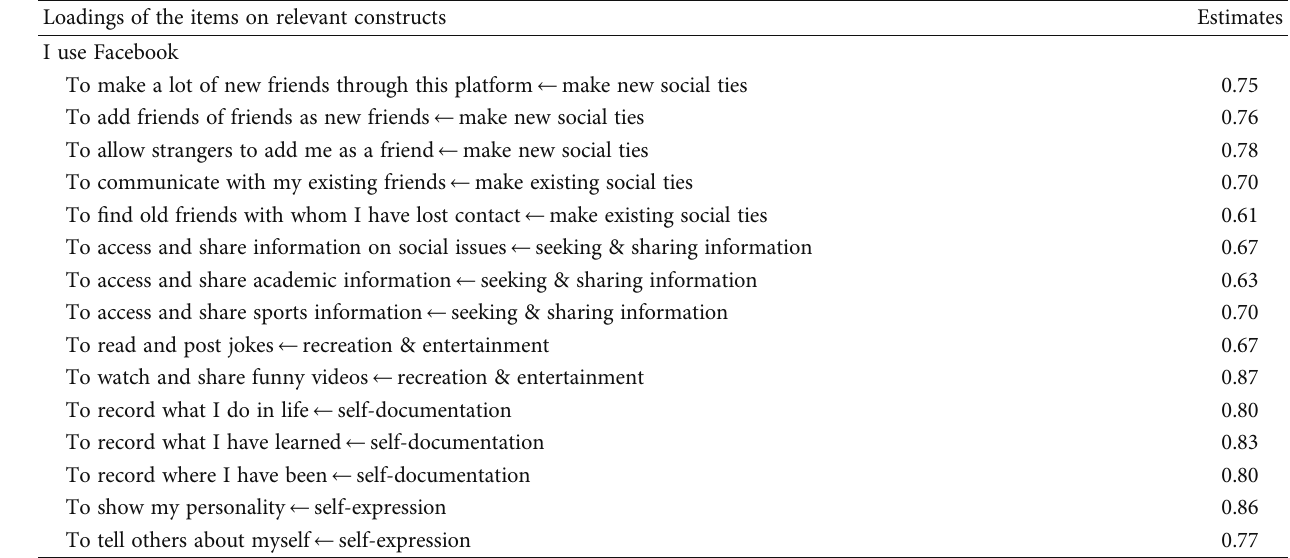
Table 4: Standardized estimates of the scale